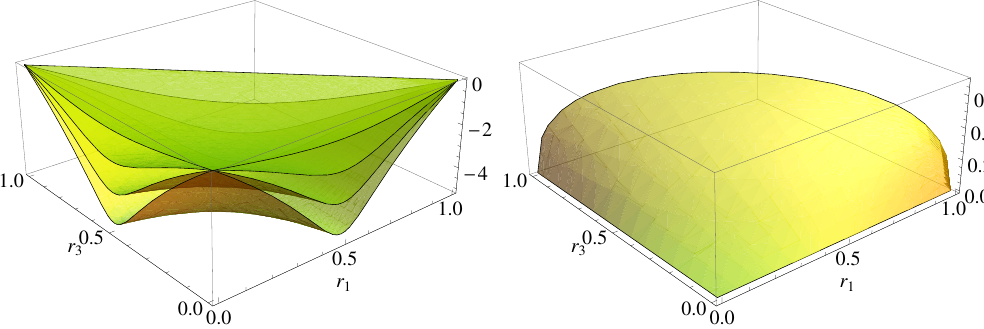
Figure 3 . Left: The function (2.3) for n (cid:16) 2 ; 4 ; 6 and 8 (the higher the value of n , the more negative the value of the function). Right: The function (2.5). As we can see, there is a change of curvature and sign when taking the limit n (cid:209) 1. A similar interesting analytic behaviour near n (cid:16) 1 was found in [37] for the compacti(cid:12)ed free boson. Recall that 0 ⁄ r 1 (cid:0) r 3 ⁄ 1, which restricts the domain of de(cid:12)nition of the functions shown. A cross-section of these surfaces is provided in (cid:12)gure 4 (left).